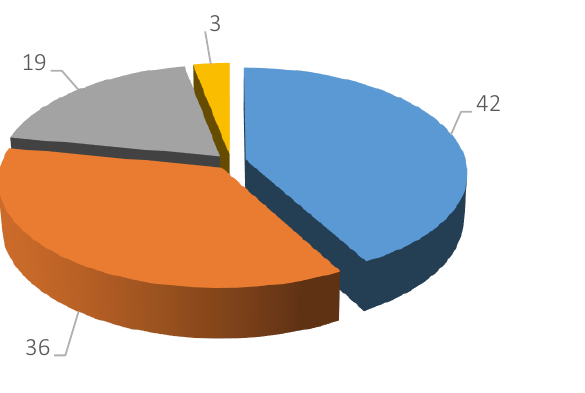
Figure 4. Distribution of research studies by thematic